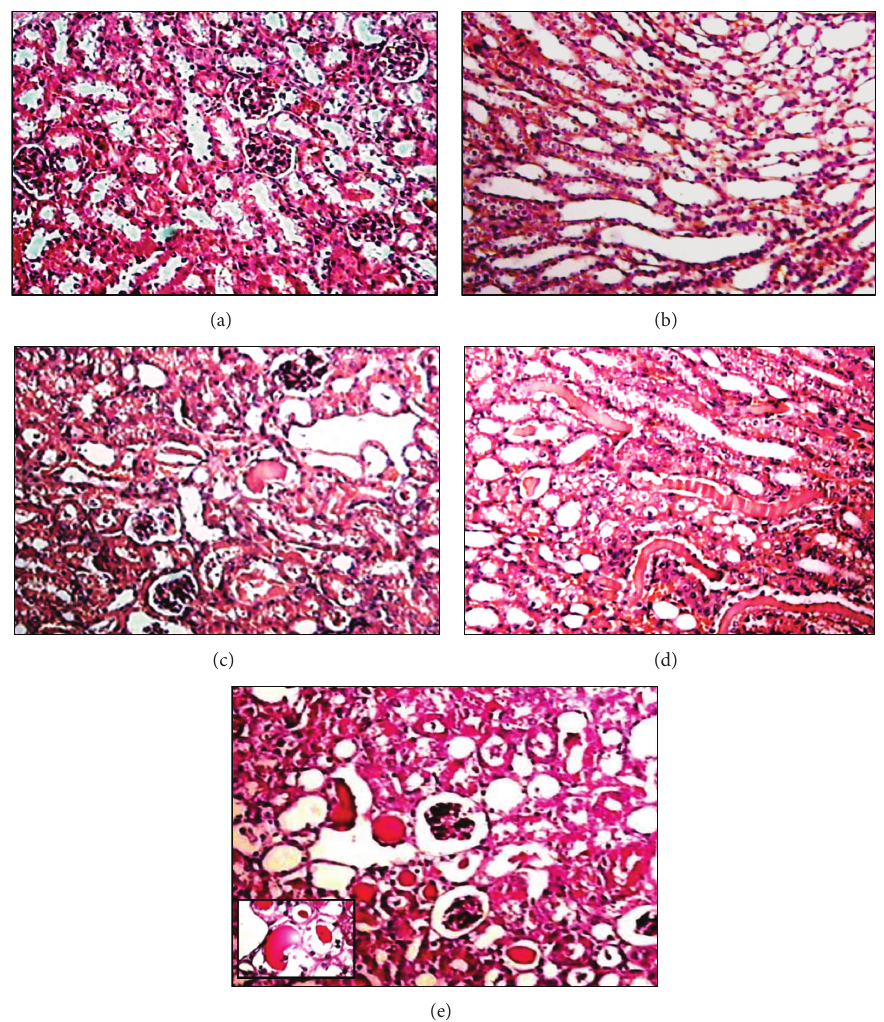
Figure 7: Kidney histological analysis of mice exposed acutely to diphenyl ditelluride 250 𝜇 mol/kg. Kidney section of control group showing (a) conserved architecture of renal cortex with convoluted tubules outlined for a single layer of cuboidal cells and preserved glomeruli and (b) renal medullar area with collecting tubule of normal morphology. Kidney of diphenyl ditelluride treated mice showing (c) tubules in different stages of compression (arrows), epithelial cells free in tubular lumen; presence of hypertrophic tubules filled with eosinophilic homogeneous substance (cast proteinaceous); (d) presence of tubules containing a single layer of epithelial cells and small vacuoles, presence of tubules filled with eosinophilic homogeneous substance (cast proteinaceous); (e) Kidney section with PAS stain, confirming the presence of cast proteinaceous in hypertrophic tubules (positive PAS stain/detail in 40x) (H&E 10x). The picture is a representation of three independent